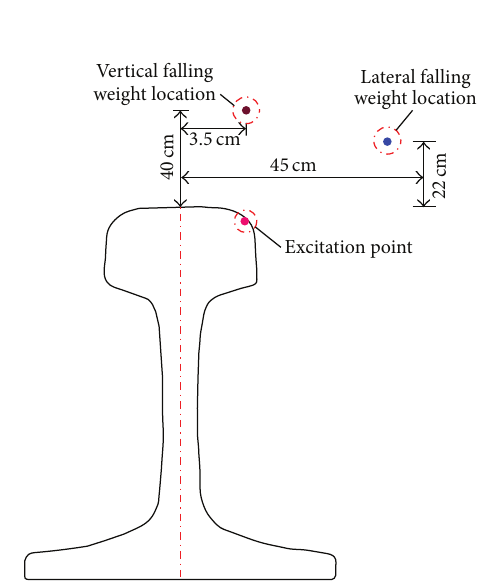
Figure 14: Accelerance of the rail foot.